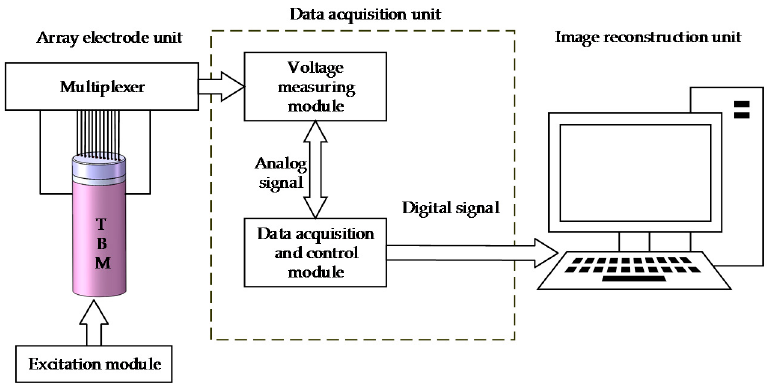
Figure 2. The composition of coal mine inclined shaft advanced detection system based on shield cutterhead moving array electrodes .